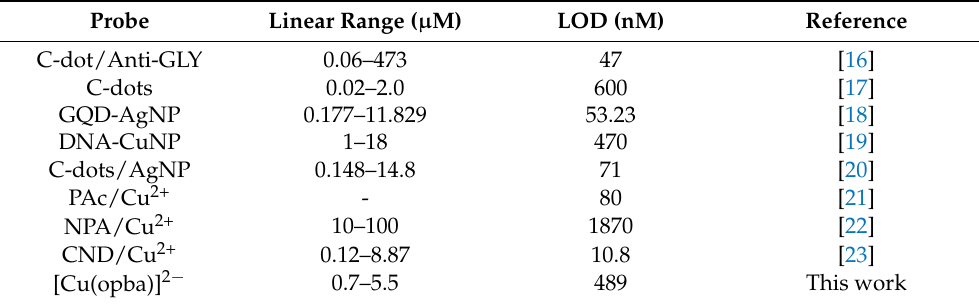
Table 1. Sensing performance of some fluorescence-based methods for the detection of